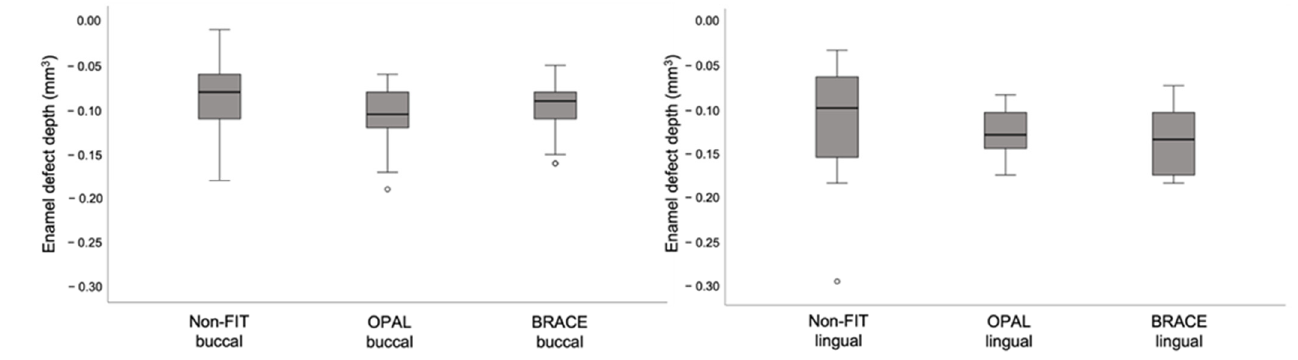
Figure 8. Box-and-whisker plot showing enamel defect depth for buccal ( left ) and lingual ( right ) in the three groups. (Note: ◦ : Mild outliers (Q1-(IQRx1.5))).